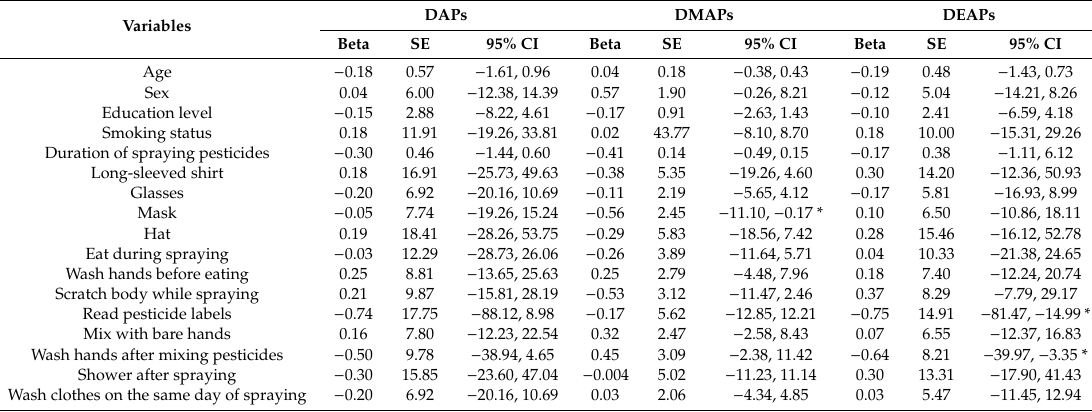
Table 6. Factors associated with DAP metabolites in pesticide